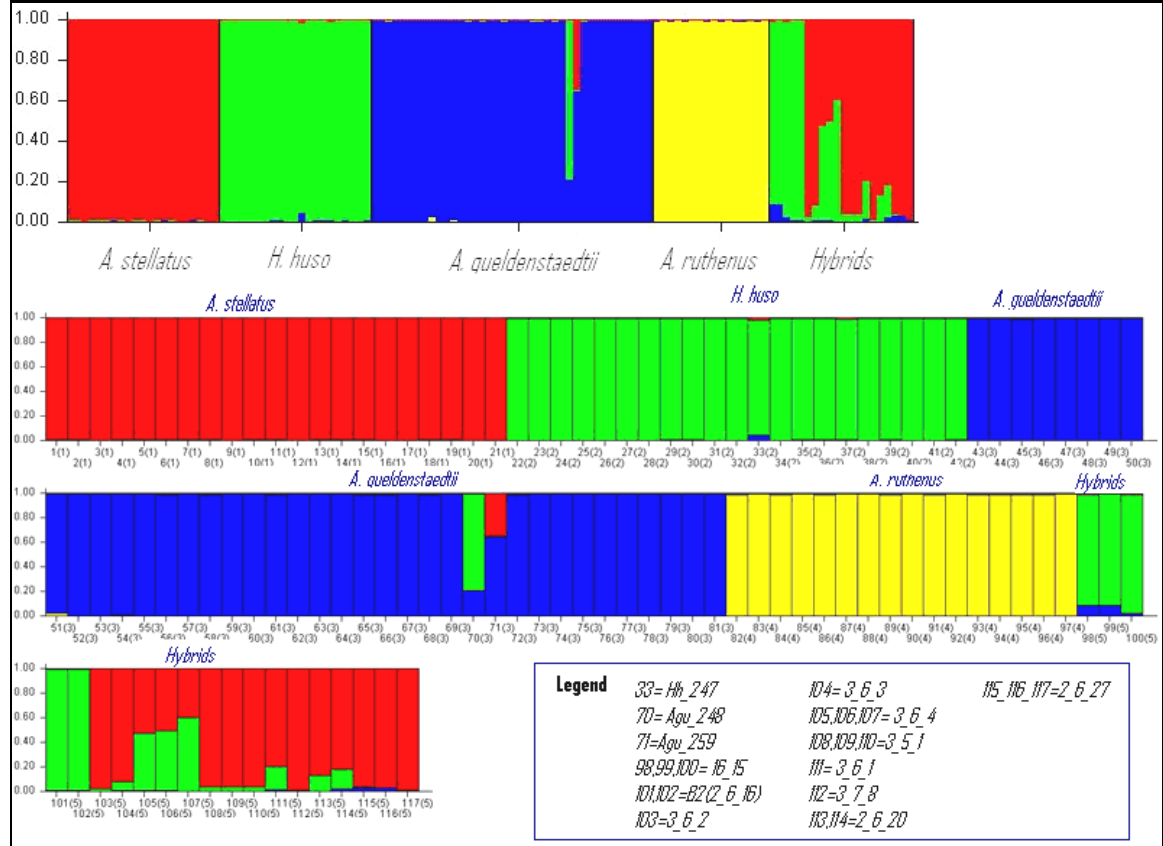
Figure 2. Assignation of the 84 sturgeons by S TRUCTURE analysis based on eight microsatellite loci in four sturgeon species from Danube. Histograms represent the estimated membership coefficients (Q). Composite bars are expected